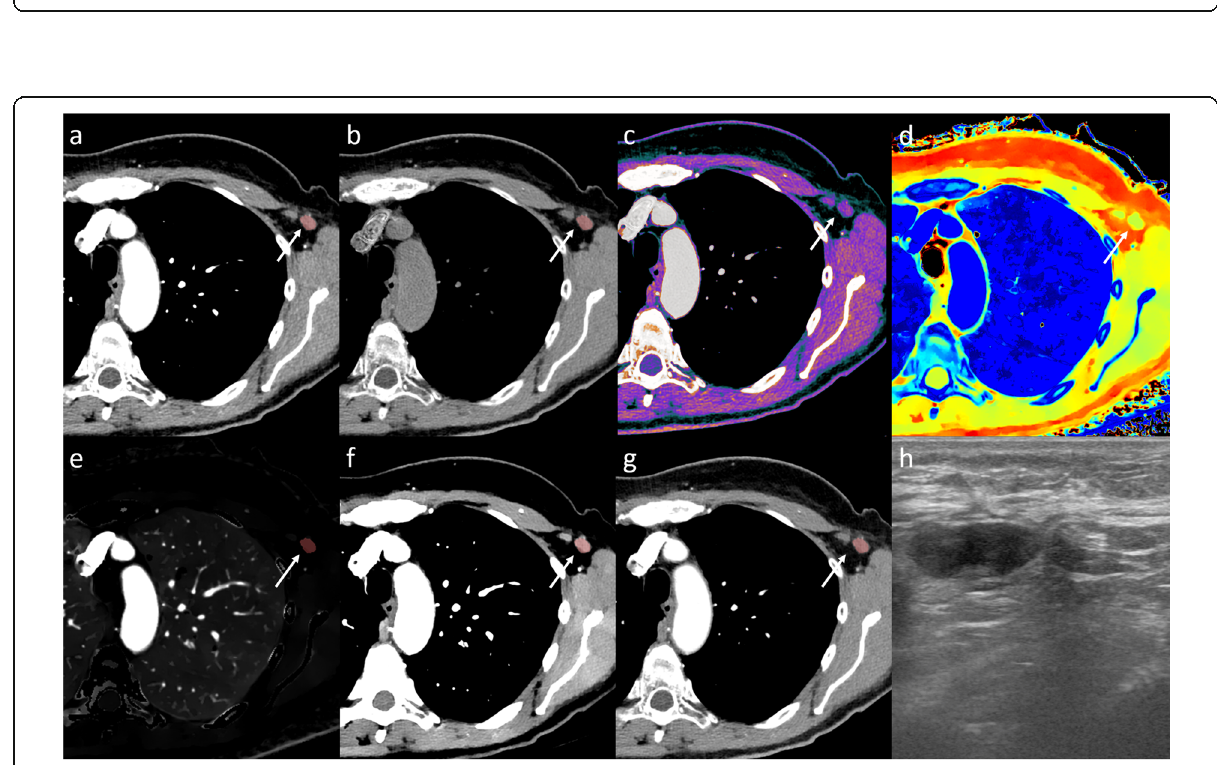
Fig. 6 Arterial phase dual-layer spectral CT (DLSCT) examination of a woman with left-sided breast cancer and a lymph node in the left axilla. The lymph node does not show increased conventional CT HU ( a ), Δ contrast enhancement ( c ) (conventional CT (HU) ( a ) minus virtual non-contrast (HU) ( b )), iodine density ( e ), or spectral slope ((mono-energy 40 keV ( f ) minus mono-energy 100 keV ( g ))/60 keV). However, Z effective ( d ) is decreased. Based on the cut-off values, both Δ contrast enhancement and conventional CT HU diagnosed the lymph node as non-metastatic. Axillary ultrasonography ( h ) described the lymph node as suspicious, and fine-needle aspiration contained malignant tumour cells. Sentinel lymph node biopsy contained malignant tumour cells from invasive ductal carcinoma